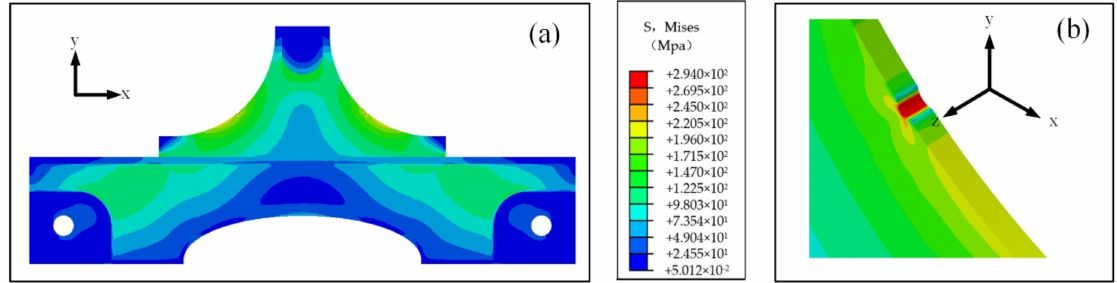
Figure 8. The ( a ) overall stress distribution and ( b ) local stress distribution of FE model with 70 kN